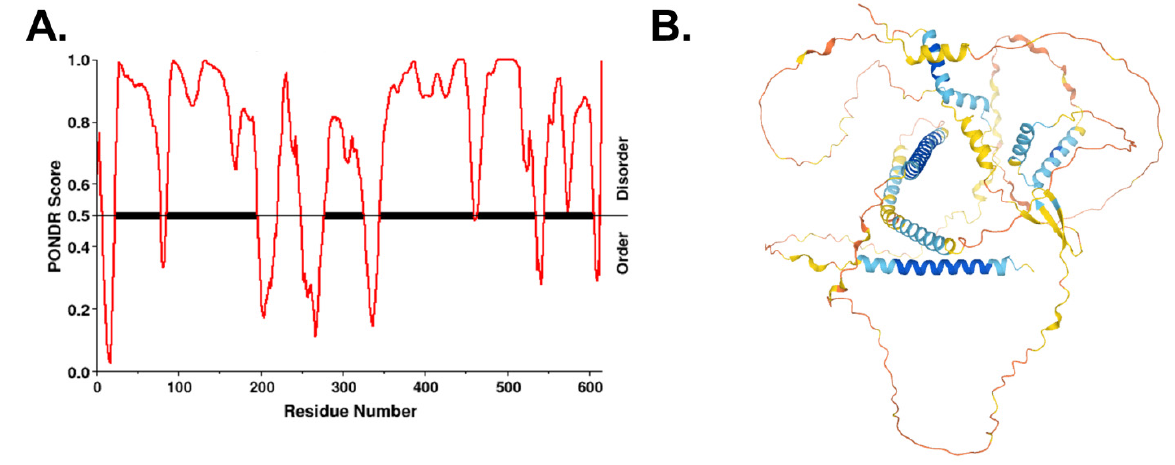
Figure 5. VGF is an intrinsically disordered protein. ( A ) Disordered regions of human VGF were identified using the VL-XT algorithm in PONDR. ( B ) Predicted folded structure of VGF was generated using AlphaFold [154,155]. Disordered regions lack secondary structure.